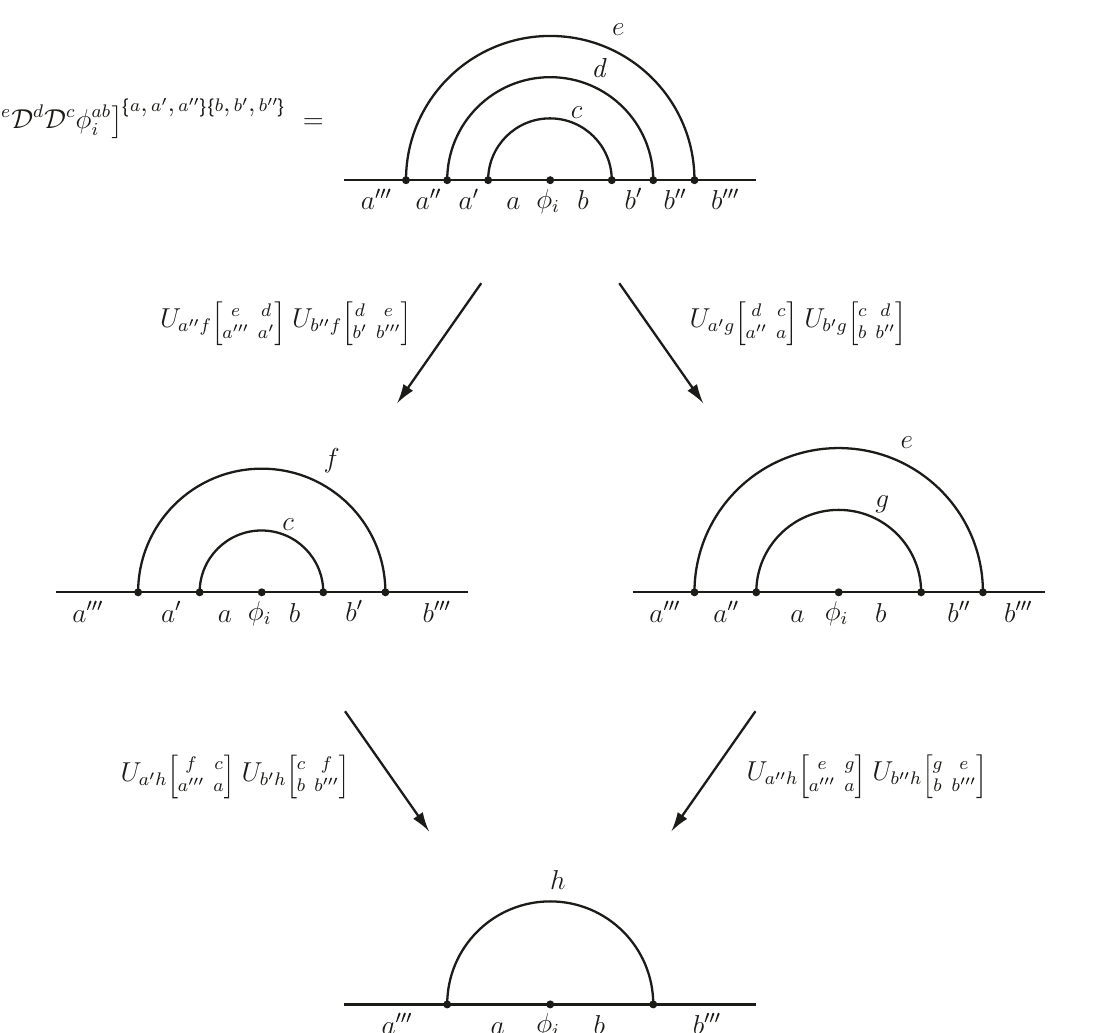
Figure 17 . Proof of associativity. Fusing together three defects attached to a boundary in two different ways results in a consistency condition (4.45) for the U matrix. The resulting condition follows from the pentagon identity for the Racah symbol